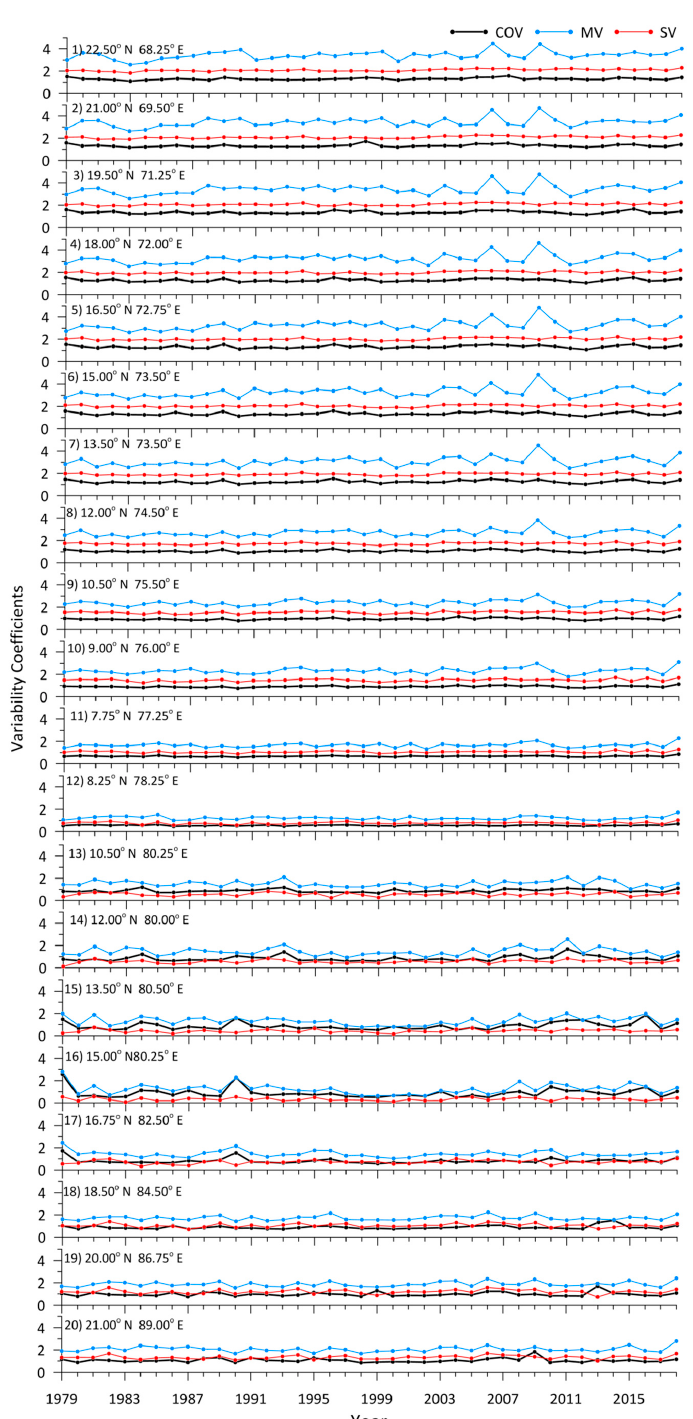
Figure 9. Variability coefficients; coefficient of variation (COV), monthly variability index (MV), and seasonal variability index (SV) calculated based on yearly data for different years at 20 locations.